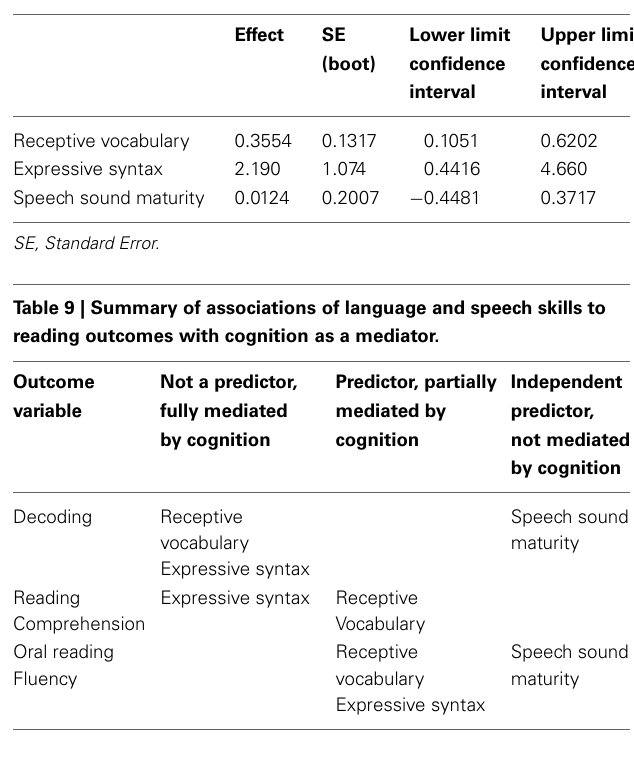
Table 8 | Indirect effect of predictor variables to mediator and mediator to oral reading fluency.